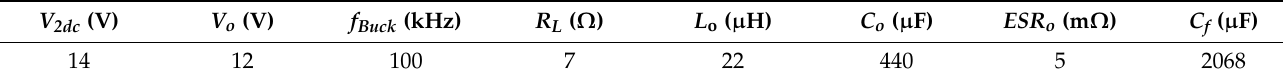
Table 2. Buck converter parameters.